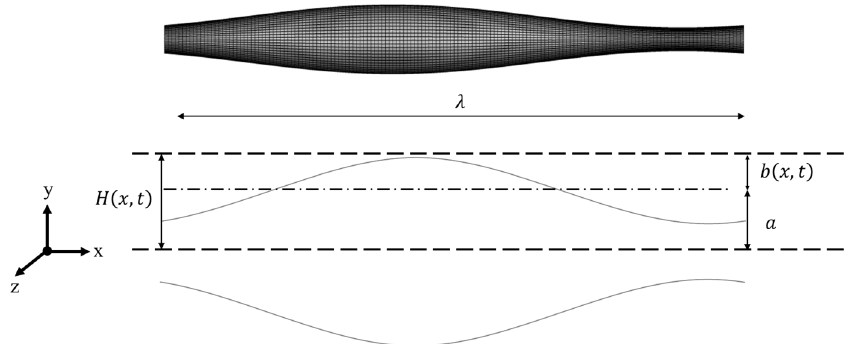
Figure 1. Illustrations of tube geometry used in the peristalsis validation model.